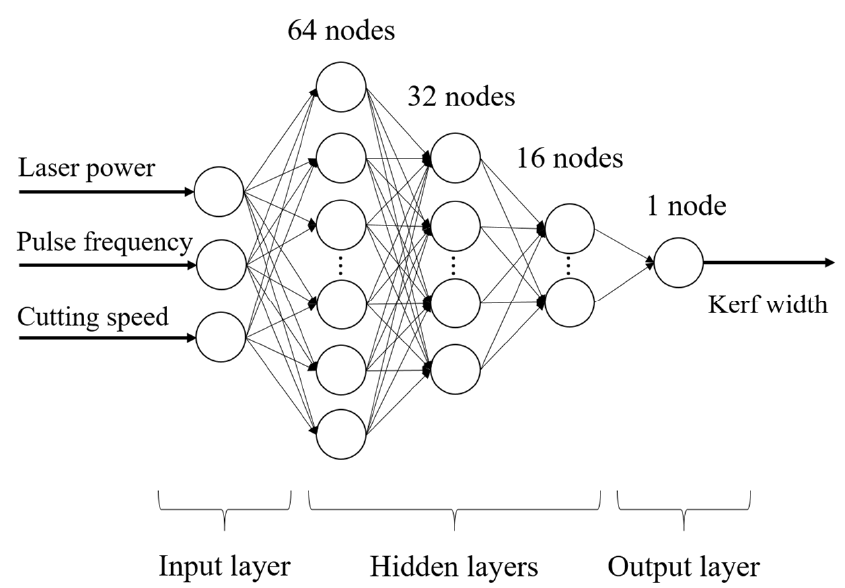
Figure 4. Structure of DNN model for kerf width prediction.